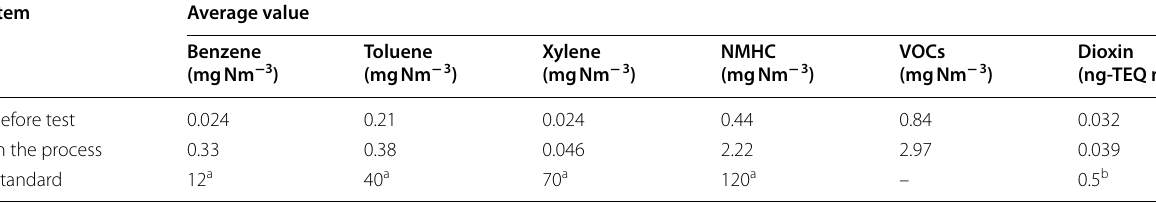
a “Integrated Emission Standard of Air Pollutants” in China (GB16297–1996) b “Emission Standard of Air Pollutants for Steel Smelt Industry” in China